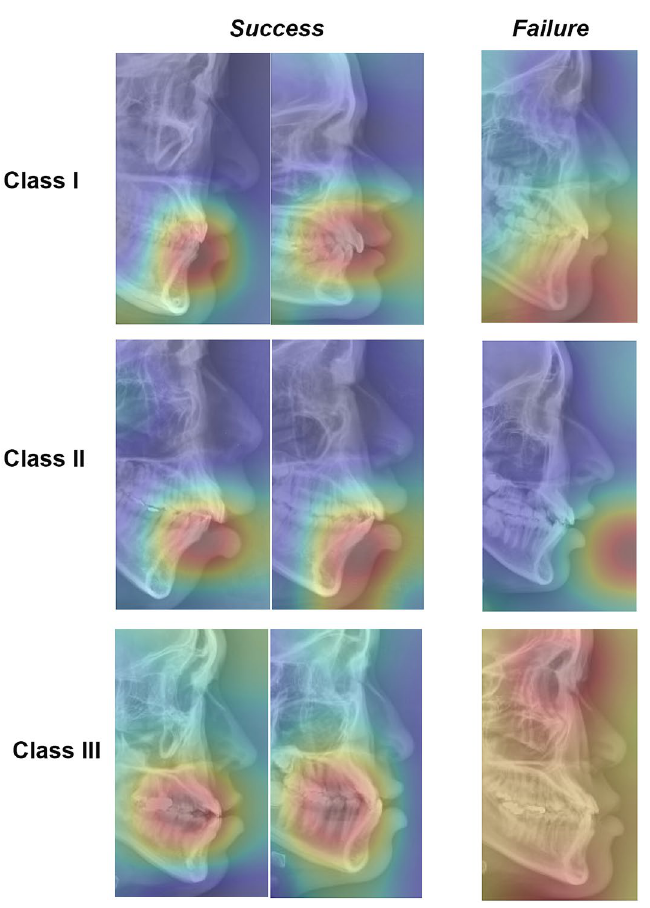
Figure 5. Class activation maps showing the regions of interest (ROI) of success and failure images (by the current DCNN